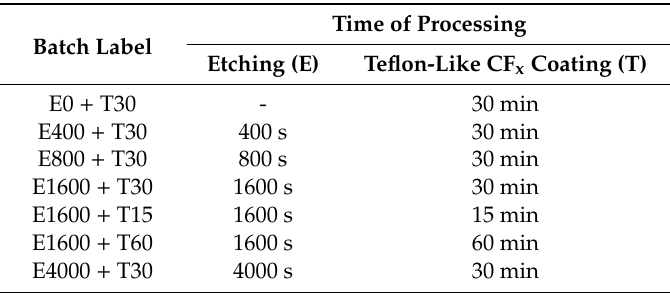
Table 1. Processing